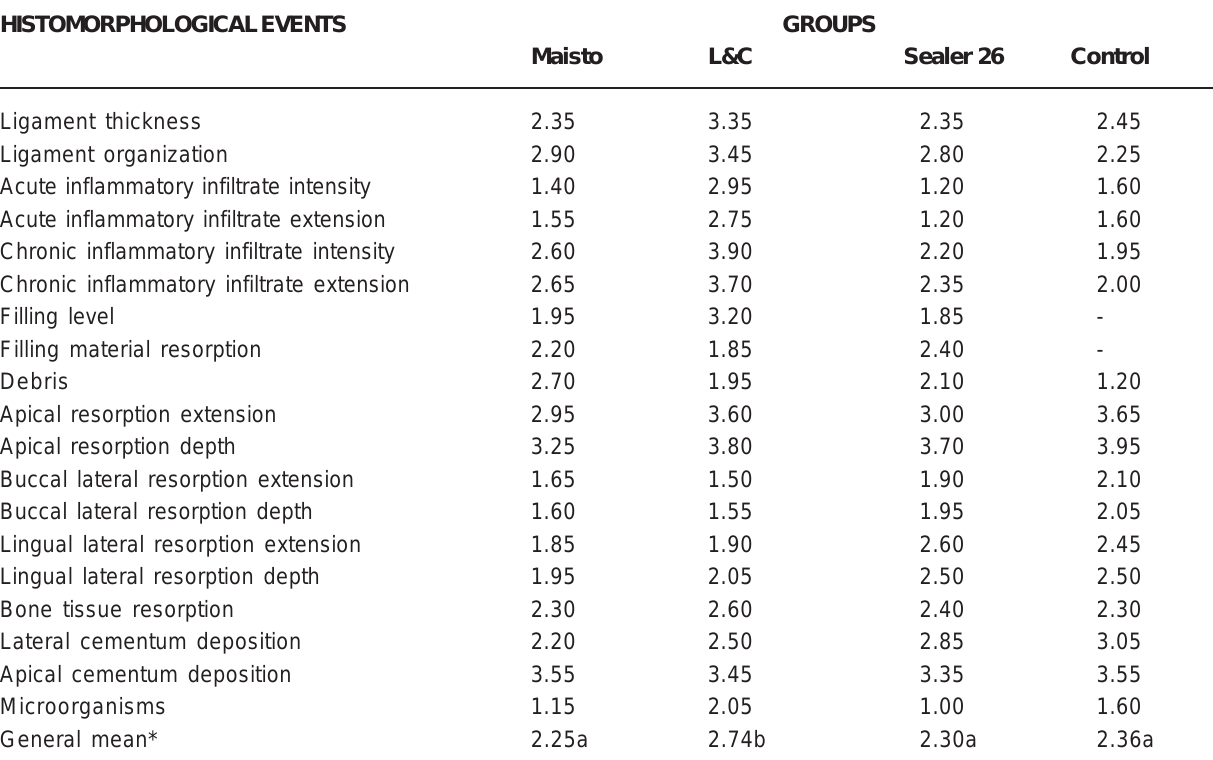
* Means followed by the same letters do not differ statistically. There was a significant difference (p=0.01) among the different